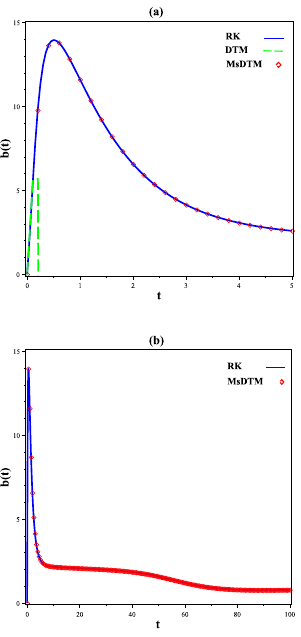
Figure 2: The density of the humans infected with avian influenza with r 0 = 1.06 and R 0 ≈ 7.1 .